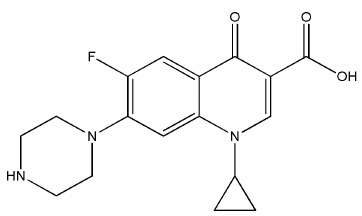
Figure 1. General chemical outline structure of ciprofloxacin. The characteristics properties of the membrane used are listed in Table 1. Table 1. Characteristic properties of UF, NF and RO